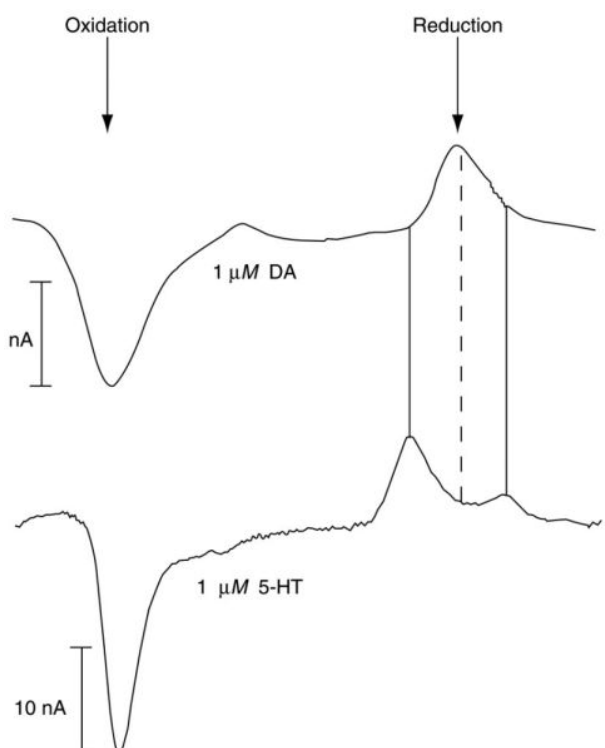
Figure 4. Dopamine (DA) and serotonin (5-HT) voltammograms. The voltammogram of dopamine 1 µ M shows one oxidation and one reduction peak. The voltammogram of serotonin 1 µ M shows one oxidation and two reduction peaks